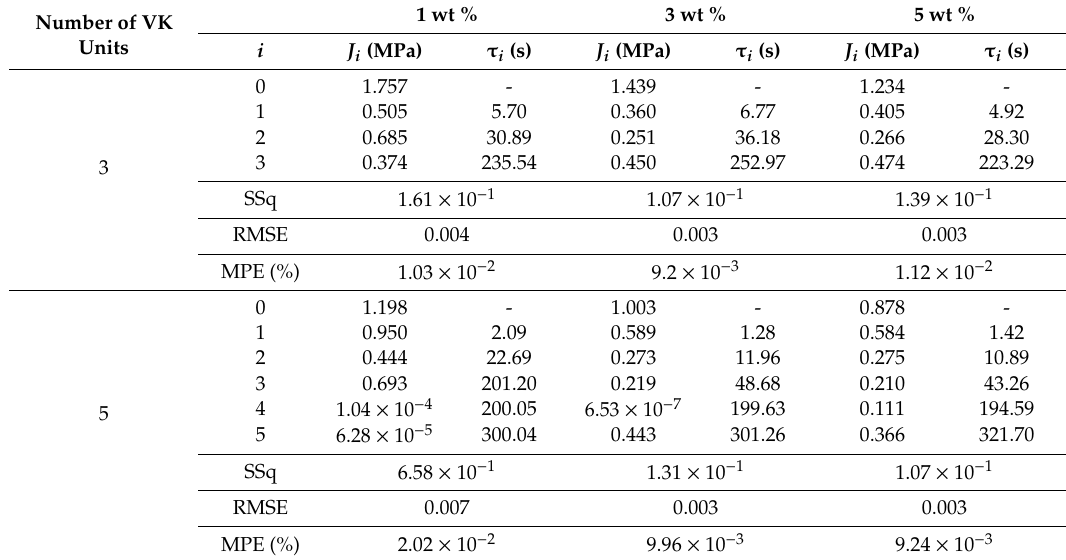
Table 2. Best fitting viscoelastic parameters for the Maxwell–Voigt–Kelvin model. Number of VK